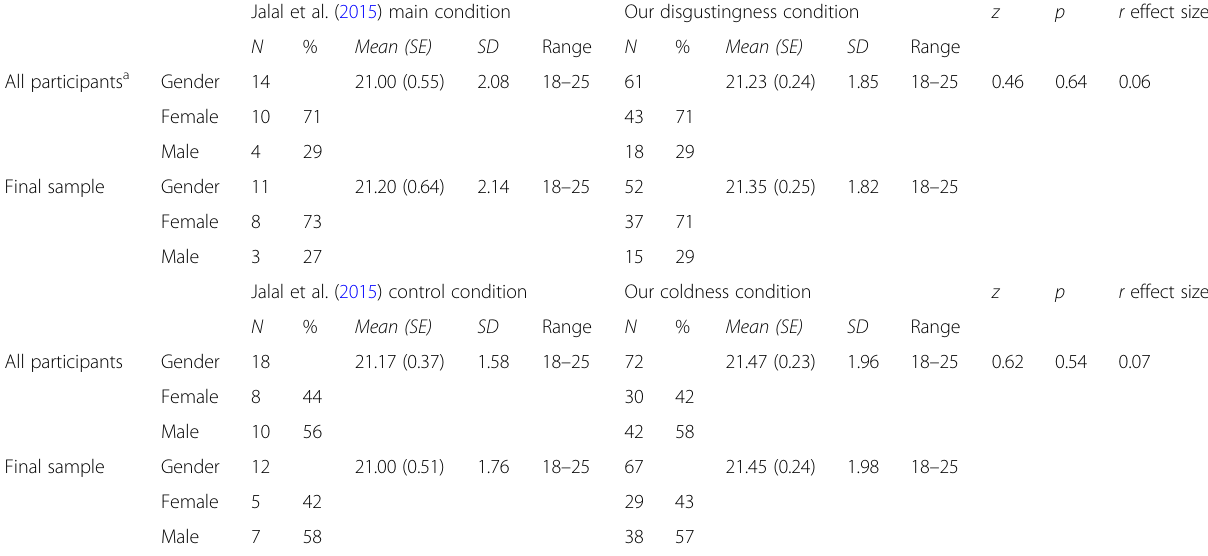
Table 4 Participant characteristics of Jalal et al. (2015) and the present study Jalal et al. (2015) main condition Our disgustingness